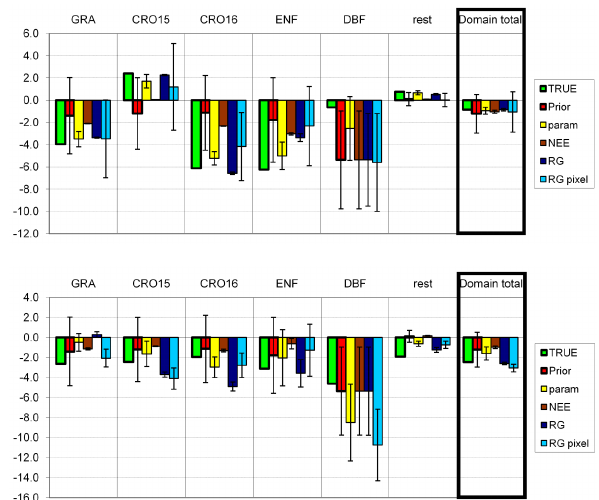
Fig. 4. True, prior and posterior NEE fluxes and their uncertainties for the different inversion methods averaged for the whole domain or per land use class [µmolm − 2 s − 1 ]. (a) Results of the control inversion, where the truth fits the biosphere model, (b) results of the inversions with an imperfect biosphere